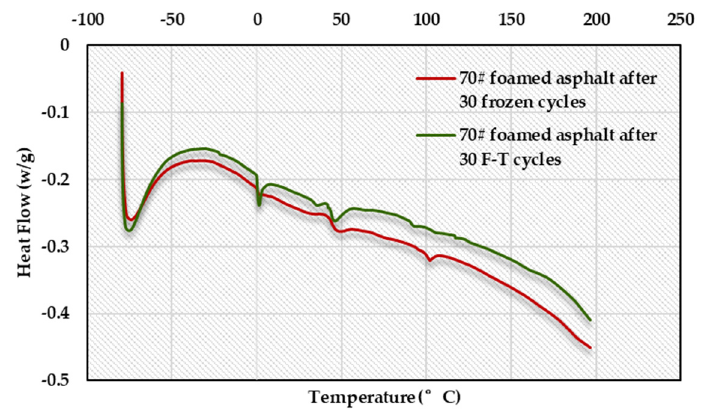
Figure 9. DSC spectrum of foamed asphalt after 30 frozen cycles and 30 F-T cycles.